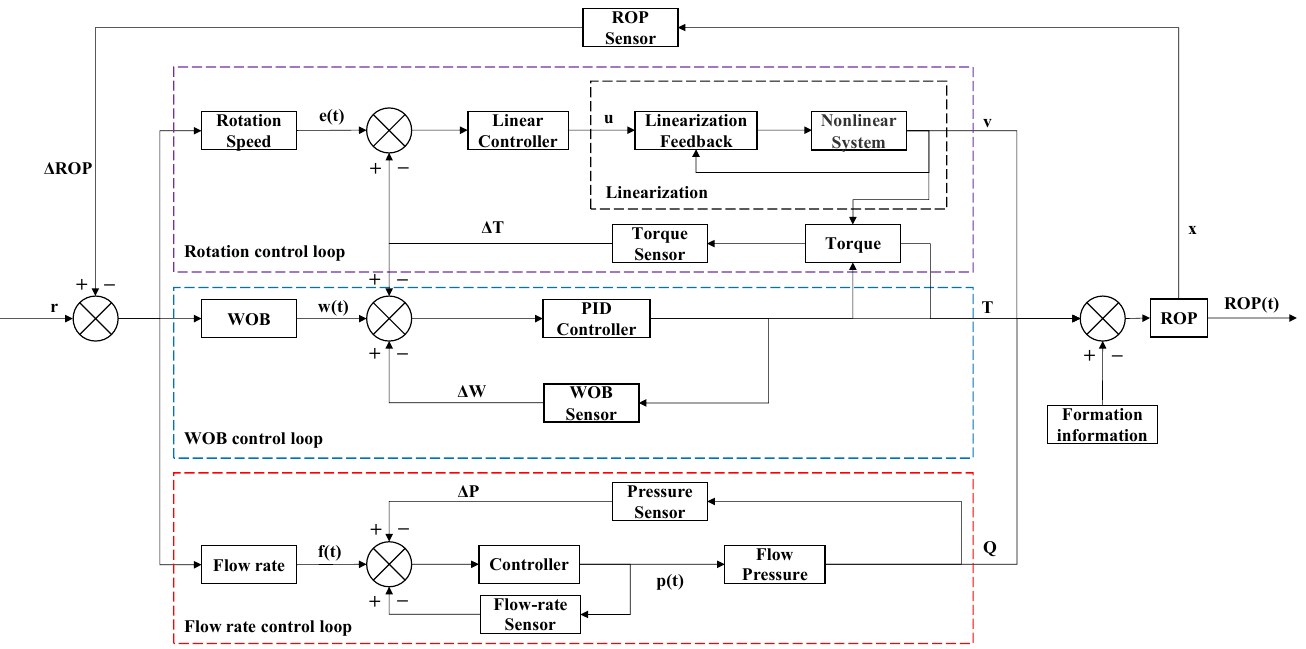
Figure 2. Control loop diagram of the automatic electric drive drilling system.